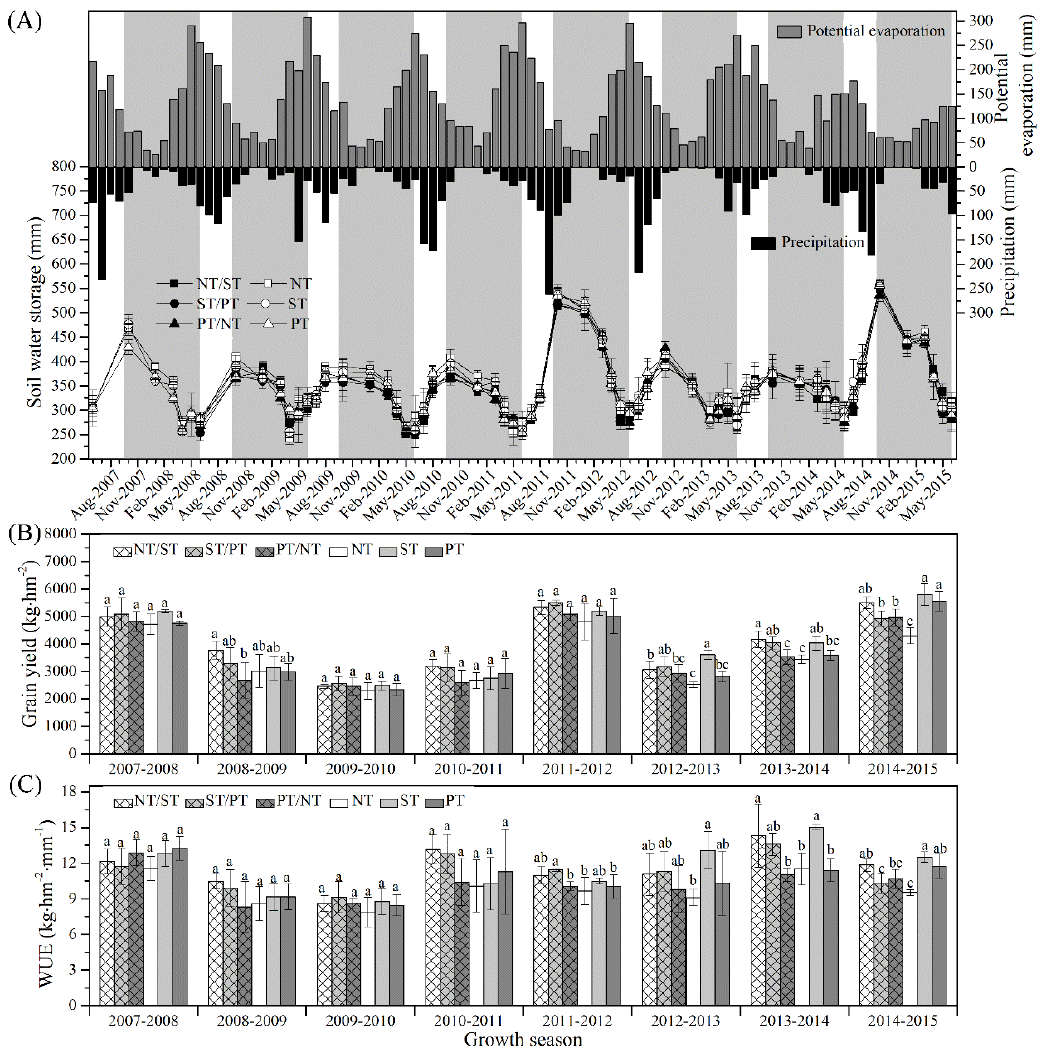
Figure 1. Soil water storage at 0–200 cm depth, precipitation and potential evaporation ( A ), wheat grain yield ( B ) and water use efficiency ( C ) from 2007 to 2015. The gray background in ( A ) represents the period of wheat growth. Different lowercase letters mean a significant difference at the 0.05 level among treatments.